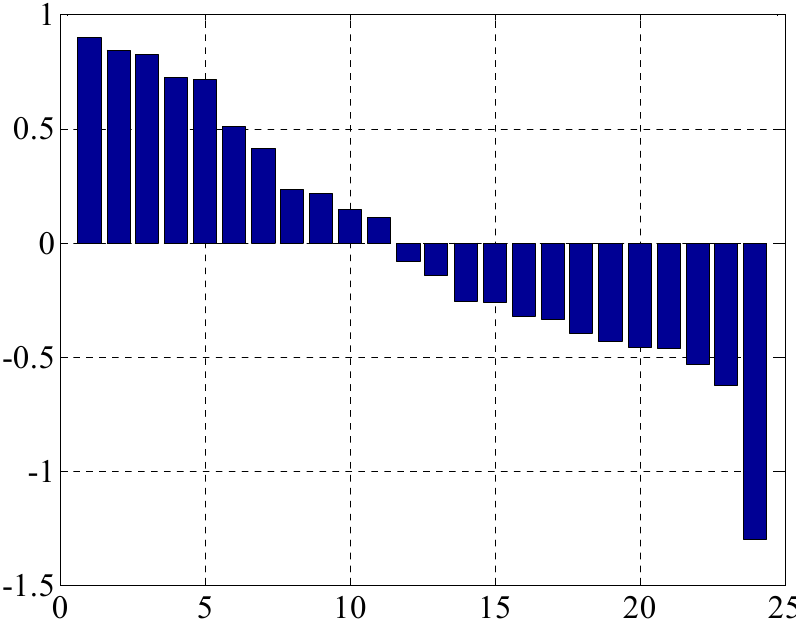
Figure 30. The ranking of performance index